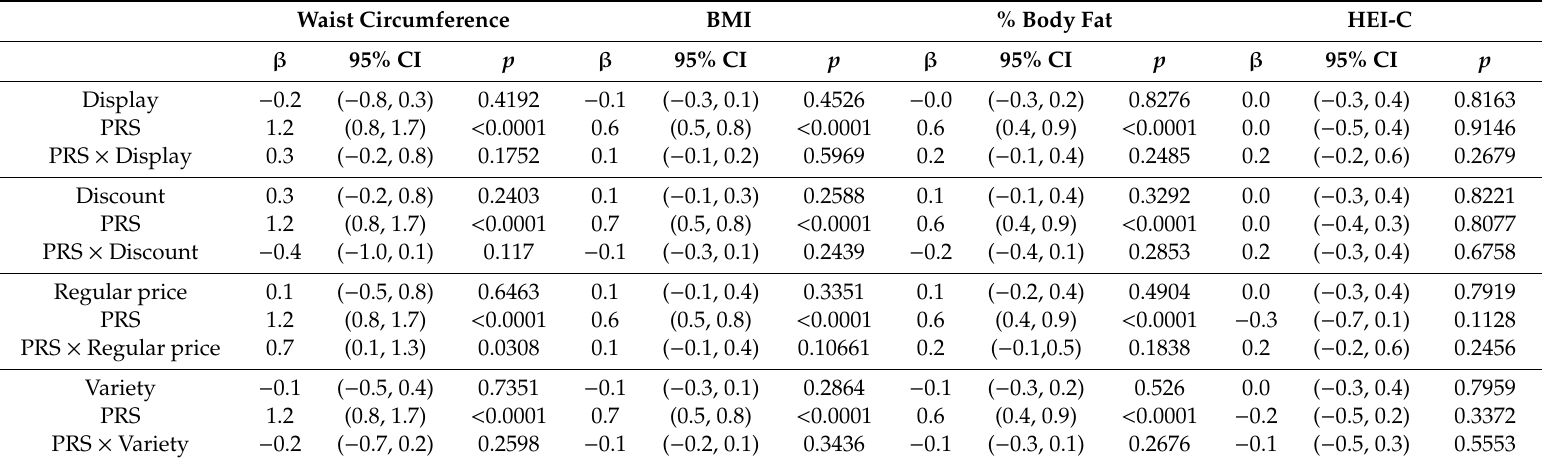
Table 6. Main and interaction e ff ects of PRS and retail food environment scores on adiposity-related outcomes (n = 3718).